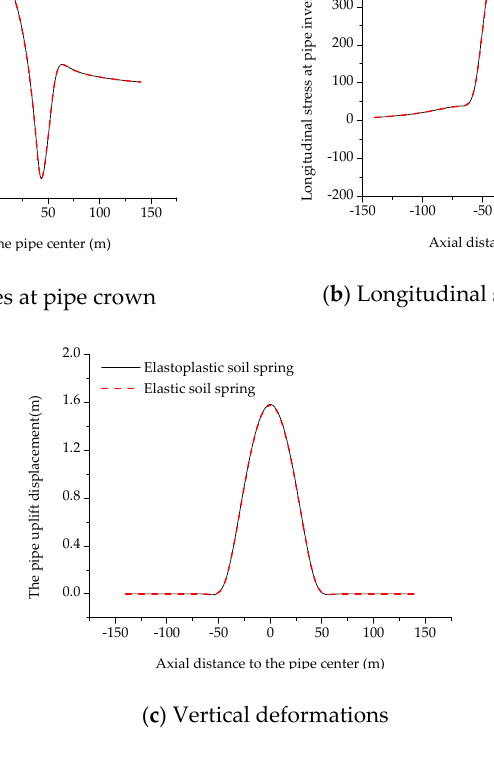
Figure 9. Results for a liquefaction zone length equal to 80 m.